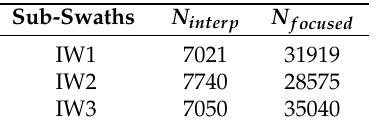
Figure 4. Flow chart of the implemented azimuth interpolation. Please note that PRF is the pulse repetition frequency, DC is the Doppler Centroid, M is the length of the sliding window, and N is the oversampling factor. Table 1. N interp and N focused values for IW1, IW2, and IW3 sub-swaths of the Sentinel-1 A/B